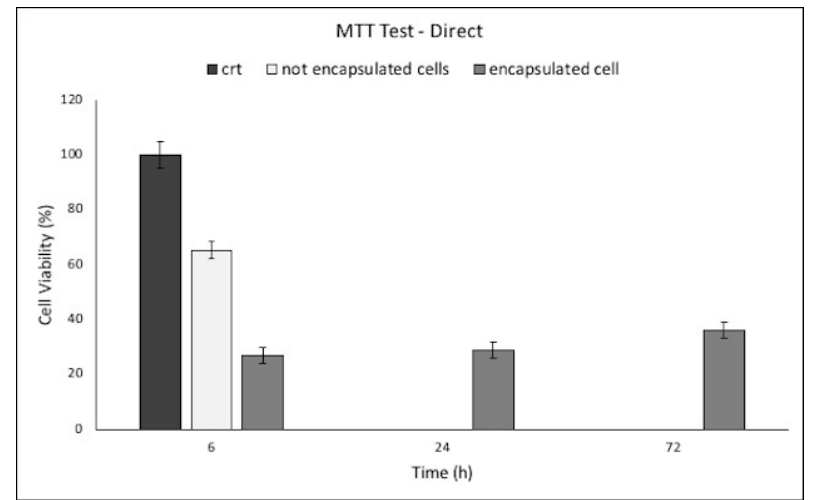
Figure 7. Results of direct 3-(4,5- dimethyl-2-thiazolyl)-2,5 diphenyl-2H-tetrazolium (MTT) test performed on human dermal fibroblasts seeded into petri dish (crt), not encapsulated cells residual from cell microencapsulation process (collected from hardening bath), and cell-loaded PMMA microcapsules (encapsulated cells).